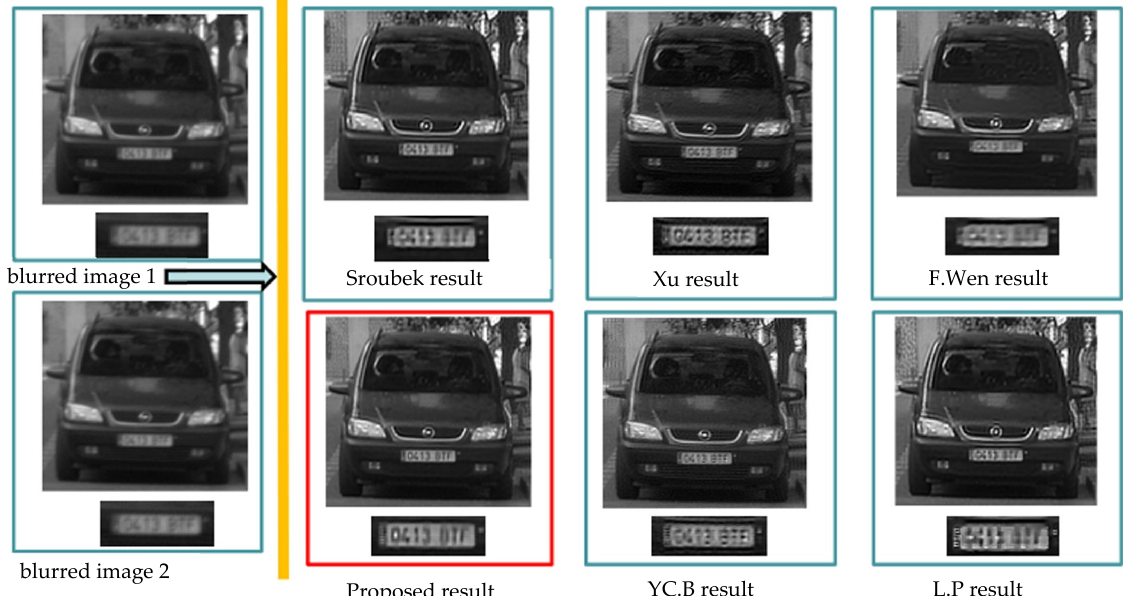
Figure 6. Sroubek’s sample restored experiment set1. On the left, the top image is the blurred image1, and the blurred image 2 is at the bottom. In the top from left to right, is the Sroubek’s result, Xu’s result, and F.Wen’s result; the bottom list, from left to right, shows the proposed method’s result, YC.B’s result, L.P’s result;.